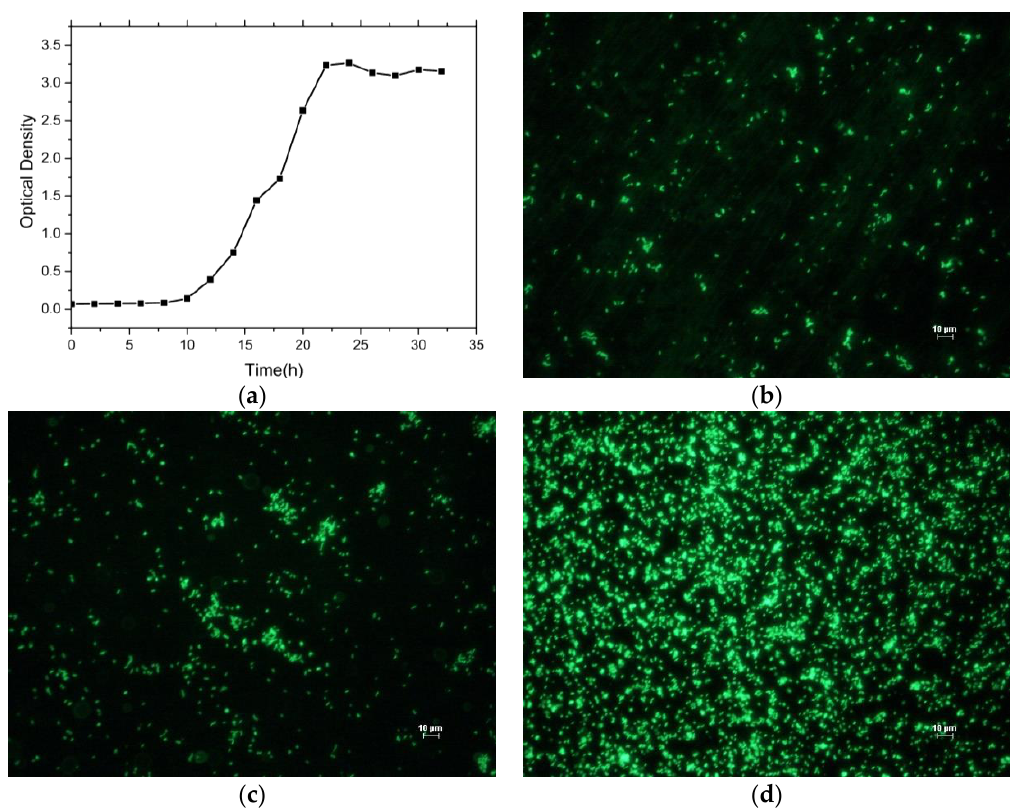
Figure 1. Sulfate-reducing bacteria (SRB) growth curve and its adsorption behavior. ( a ) Growth curve of the SRB, ( b ) the adsorption behavior of SRB for 1 day, ( c ) the adsorption behavior of SRB for 2 days, and ( d ) the adsorption behavior of SRB for 5 days.